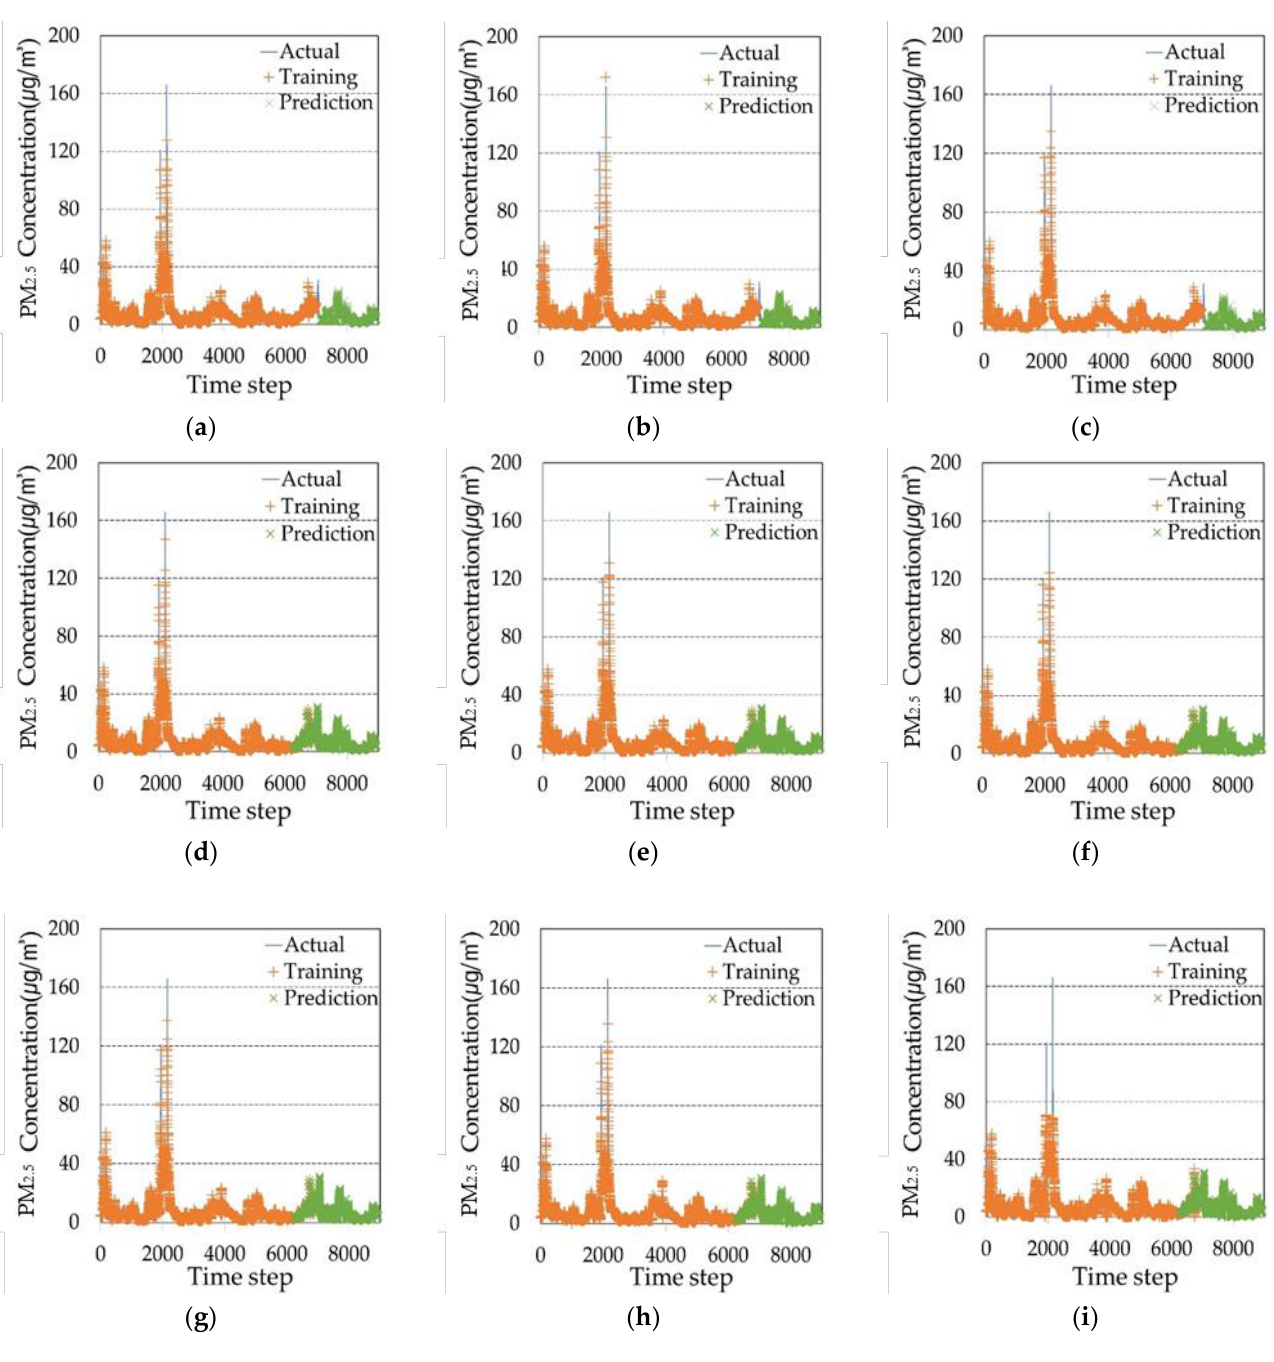
( i ) Figure 4. R 2 of prediction results of CO 2 concentration. ( a ) LM-Hidden layer-1; ( b ) LM-Hidden layer-3; ( c ) LM-Hidden layer-5; ( d ) BR-Hidden layer-1; ( e ) BR-Hidden layer-3; ( f ) BR-Hidden layer-5; ( g ) BFG-Hidden layer-1; ( h ) BFG-Hidden layer-3; ( i ) BFG-Hidden layer-5.